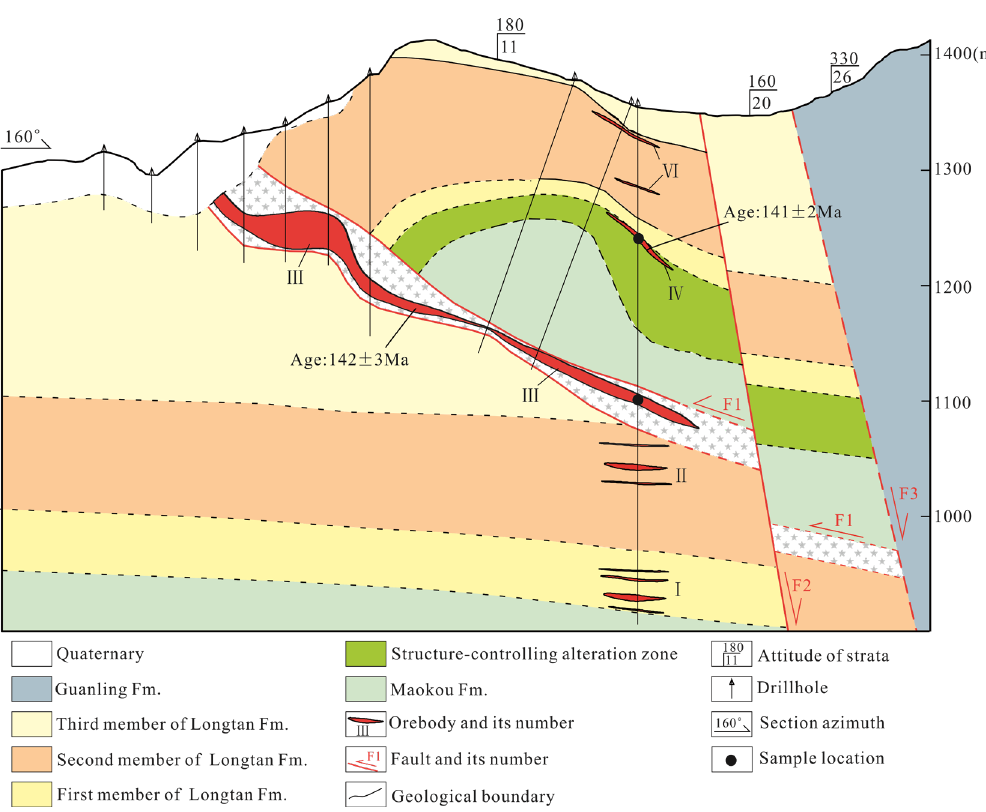
Figure 3. Cross section along the 9460 exploration line of the Nibao gold deposit.